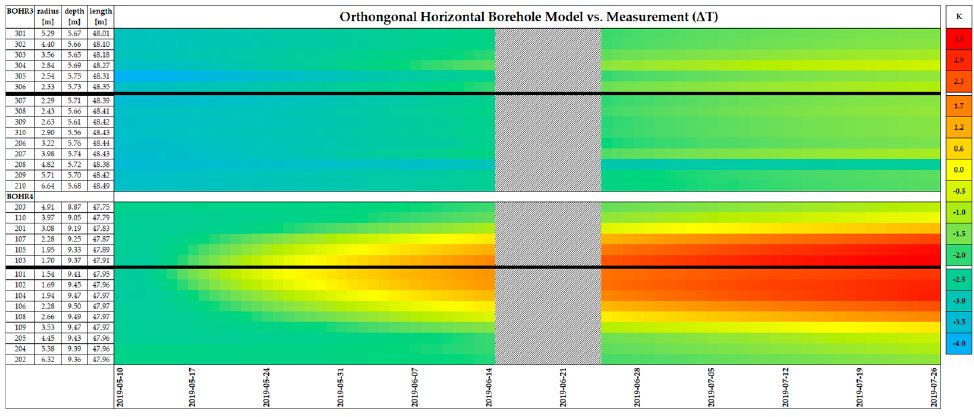
Figure 26. BOHR3 and BOHR4 modeled temperatures plotted against measured temperatures.